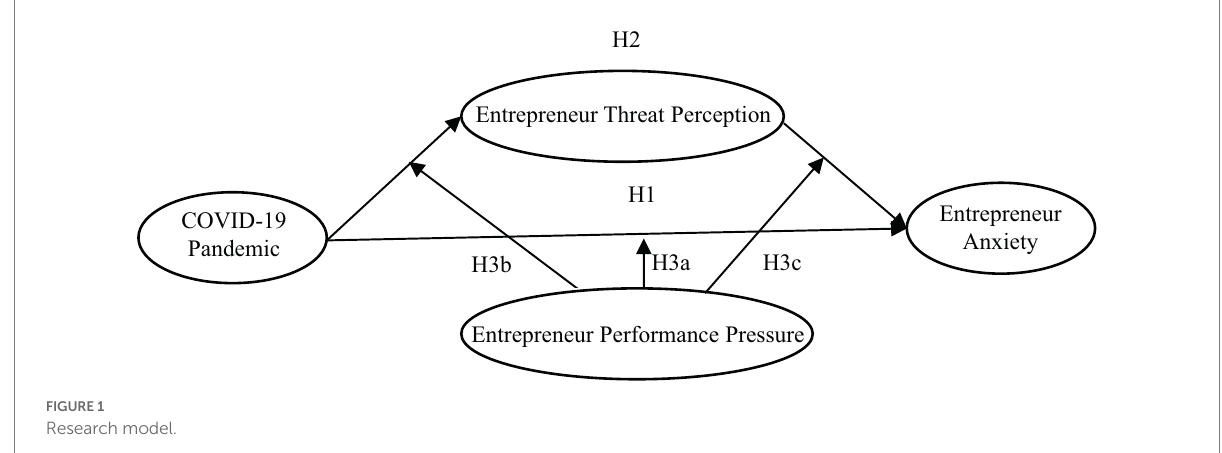
FIGURE 1 Research